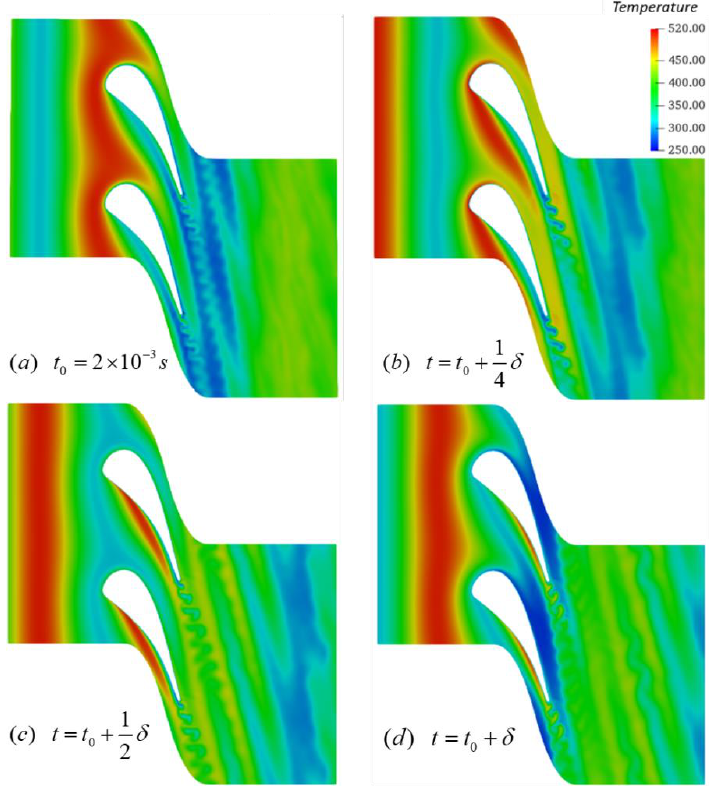
Figure 7. Distribution of instantaneous temperature fields at different times within one period δ = 2 π / ω = 1 ms .